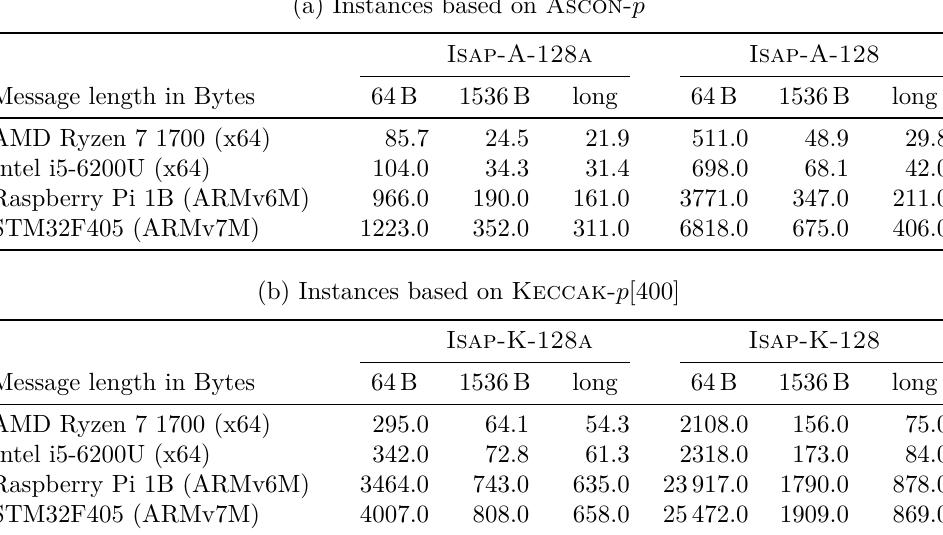
Table 4: Encryption performance of Isap in cycles/byte for different message lengths. (a) Instances based on Ascon- p